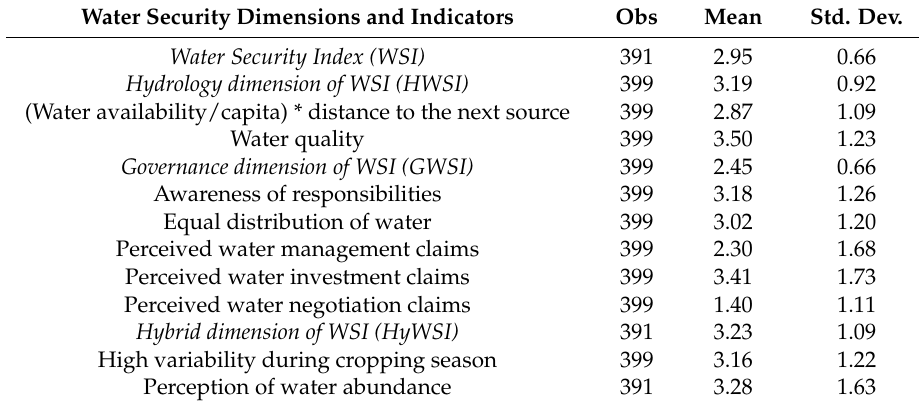
Table 2. Descriptive statistics of the three dimensions.